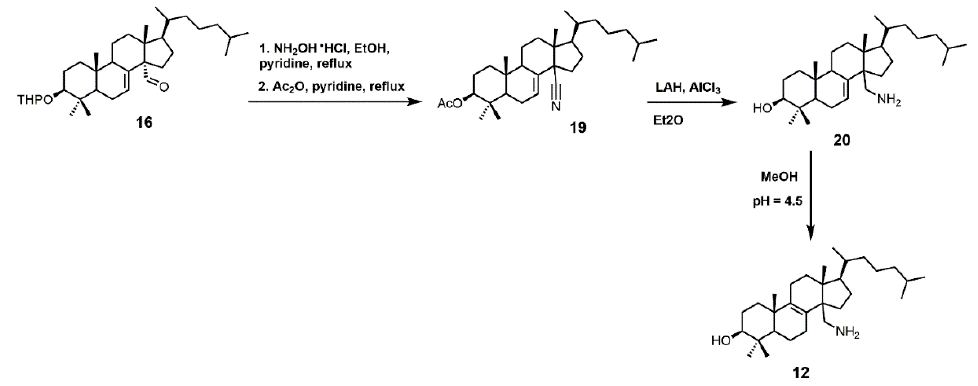
Figure 10. The synthesis of 4,4-dimethyl-14 α -aminomethyl-cholest-8-en-3 β -ol ( 12 ).